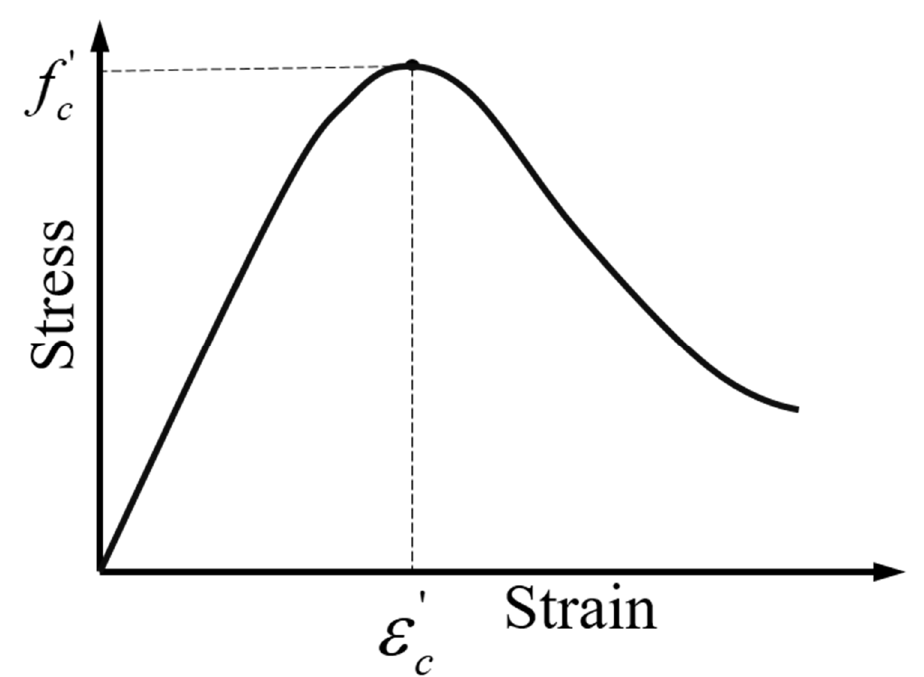
Figure 6. Mean strain Mohr circle.